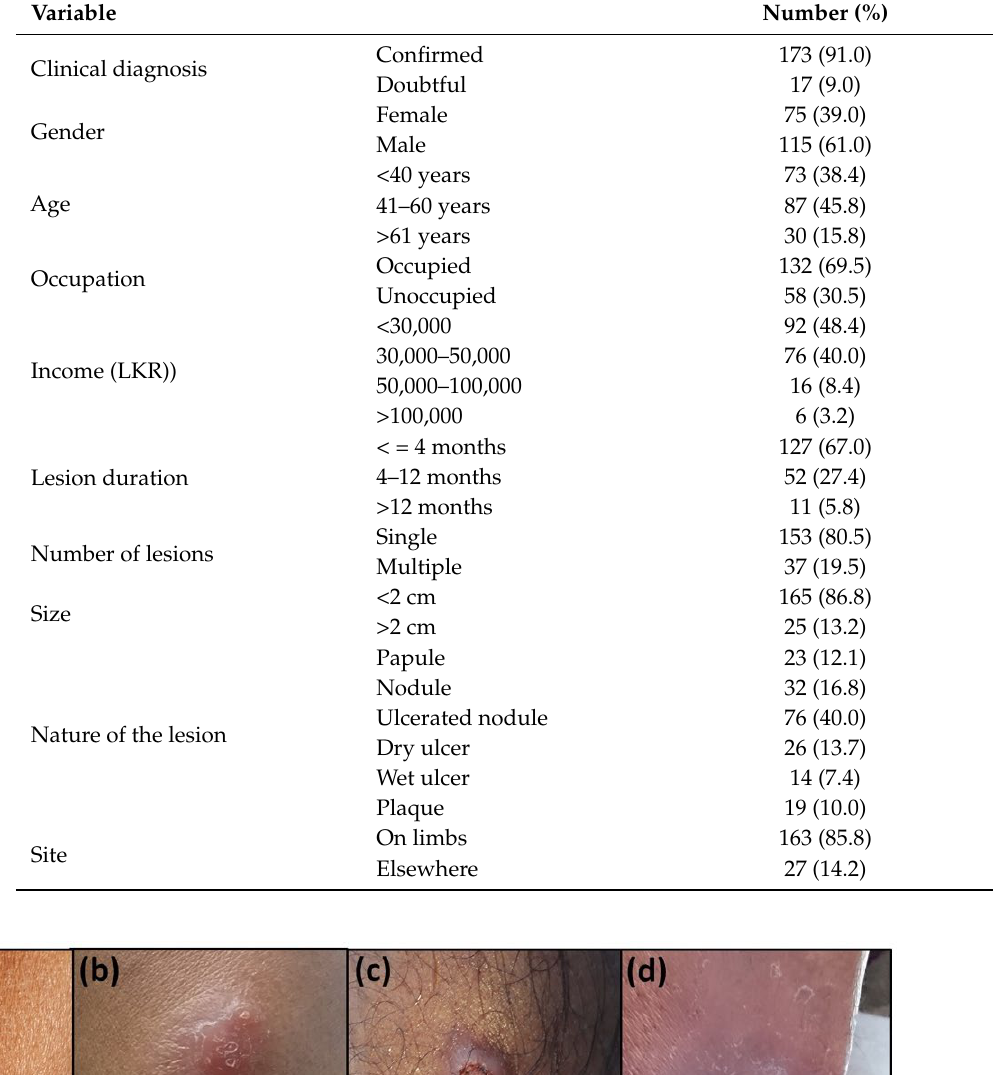
Table 1. Clinical and demographic characteristics of the CL cohort ( n = 190) .